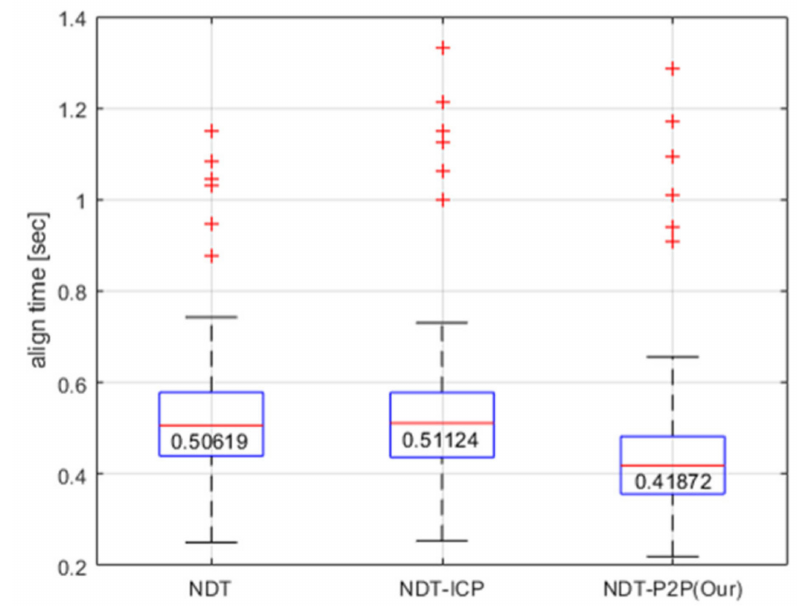
Figure 8. The process time by algorithm.